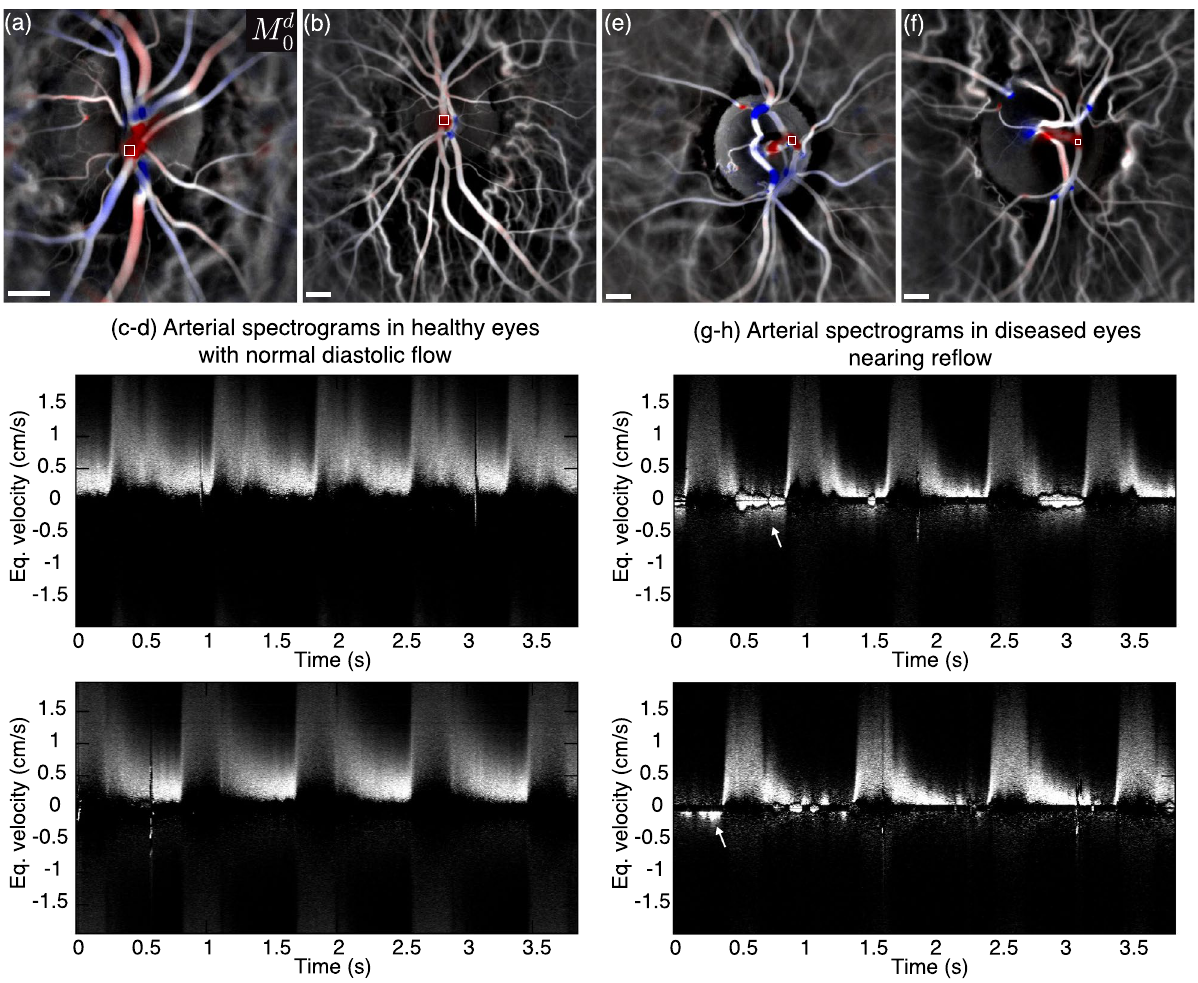
Figure 5. Example of spectrograms in healthy and diseased eyes. ( a , b ) In the two healthy eyes the arterial flow is anterograde throughout the whole cardiac cycle. In these cases of ( c ) central retinal vein occlusion and ( d ) high tension glaucoma, the diastolic arterial flow is below the limit where LDH can reliably monitor blood flow variations. The estimated size of the scale bar is 500 µ